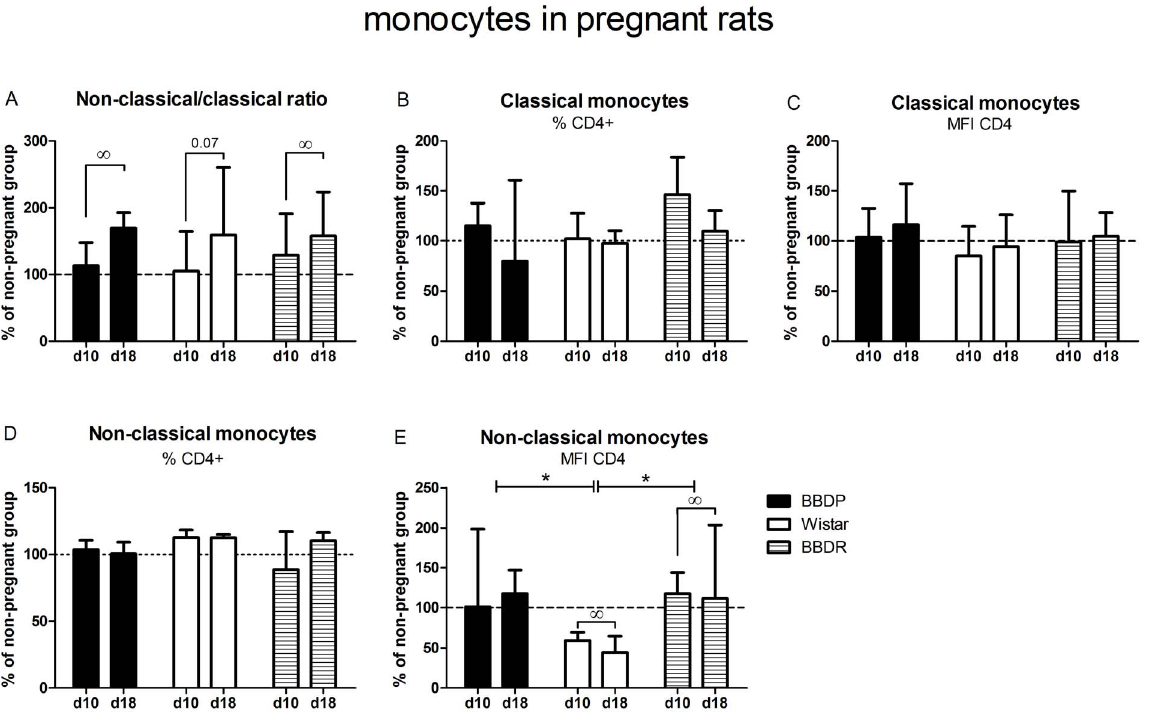
Figure 6. Monocyte subpopulations in pregnant rats. Values of day 10 or 18 of pregnancy are recalculated regarding the median values of non-pregnant animals (which was set at 100%) to express (as median (Q 1 –Q 3 )) pregnancy-induced changes. [A] The adaptations to pregnancy in the ratio non-classical/classical monocytes, [B] the percentage of CD4 + classical monocytes, [C] the MFI of CD4 on classical monocytes, [D] the percentage of CD4 + non-classical monocytes and [E] the MFI of CD4 on non-classical monocytes of each strain during pregnancy. d10/d18: day 10 or 18 of pregnancy. ‘ slope significantly different from zero (Regression-analysis, ANCOVA, p , 0.05). *slope significant different between the marked strains (Regression-analysis, ANCOVA, p ,